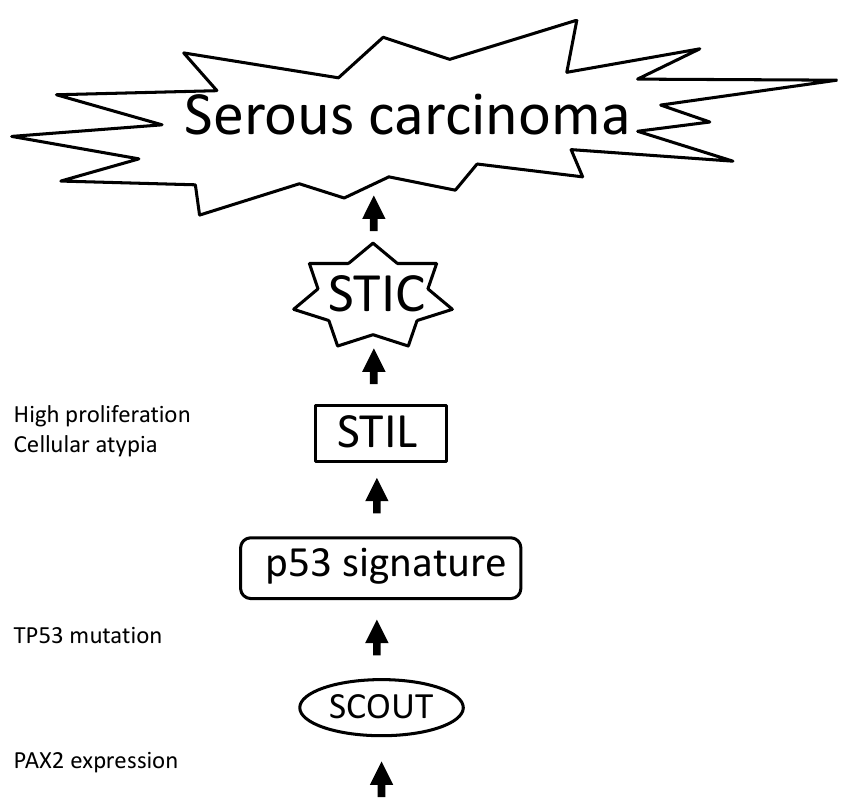
Figure 3. Carcinogenesis of ovarian serous carcinoma. Secretory cell outgrowth (SCOUT) occurs from secretory cells in the fallopian tube, expressing PAX2. The p53 signature develops from SCOUT with TP53 mutation. The p53 signature acquires the activity of high proliferation and cellular atypia, resulting in development of serous tubal intraepithelial carcinoma (STIC) via serous tubal intraepithelial lesions (STILs). STIC progresses to ovarian serous carcinoma.